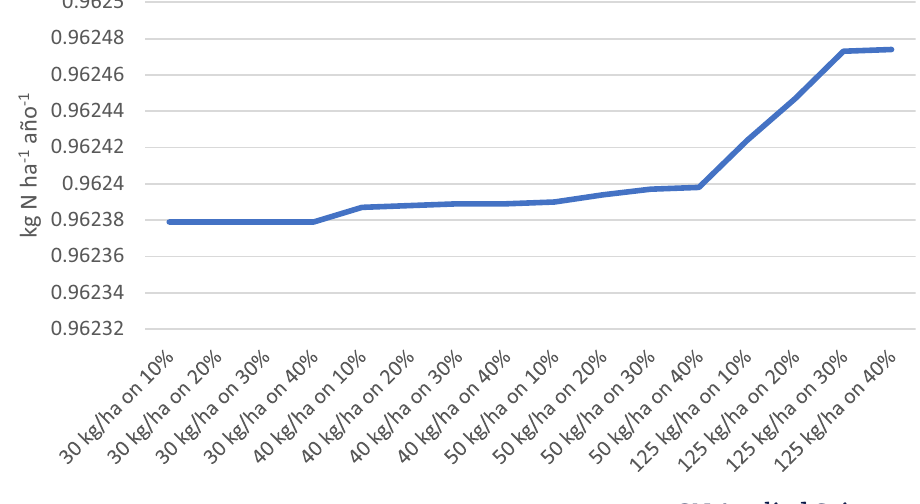
Fig. 14 Maximum nutrients export to the gulf for each of the